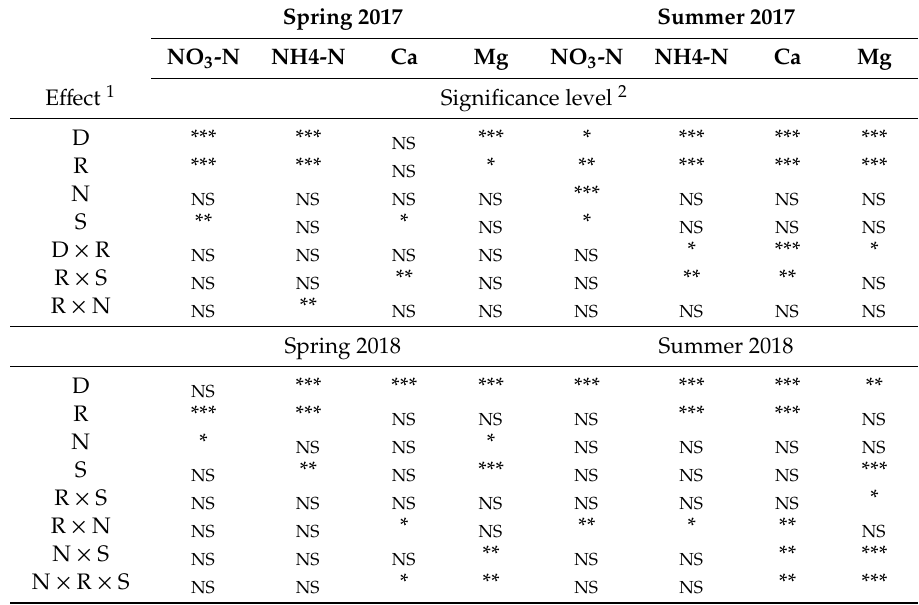
Table 3. Analysis of variance (ANOVA) of soil nutrient concentration on a dry weight basis in Huanglongbing (HLB)-a ff ected Hamlin citrus